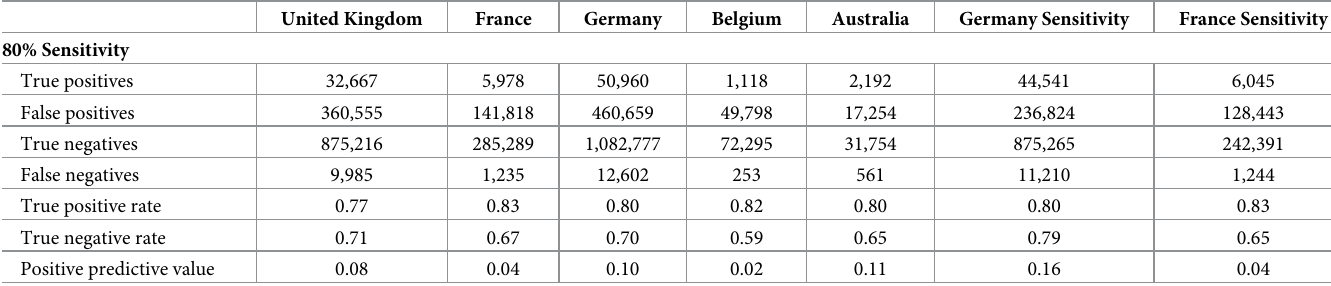
Table 3. Measures of predictive performance of the model at ~80% sensitivity.